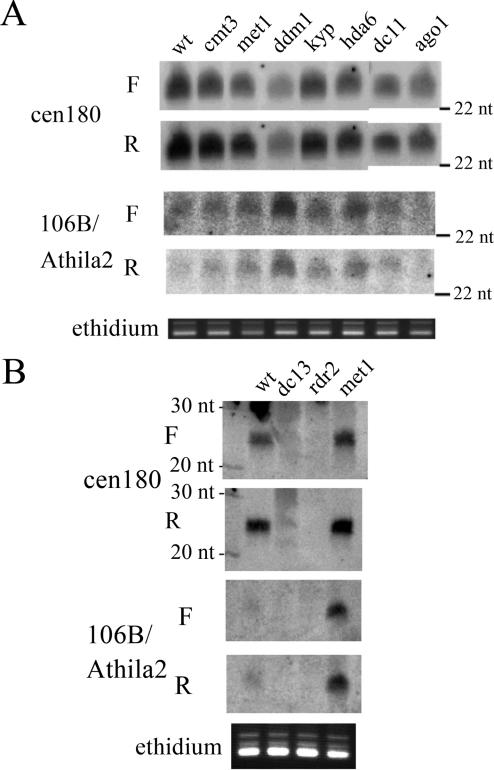
siRNAs from Centromeric RepeatsTotal RNA was purified from plants of the indicated genotypes, and small RNAs were enriched by solubility in PEG (see Materials and Methods). Mutants and WT (wt) were in the Landsberg erecta background (A) or the Columbia background (B). RNA was prepared from aerial tissues from 28-day-old plants.